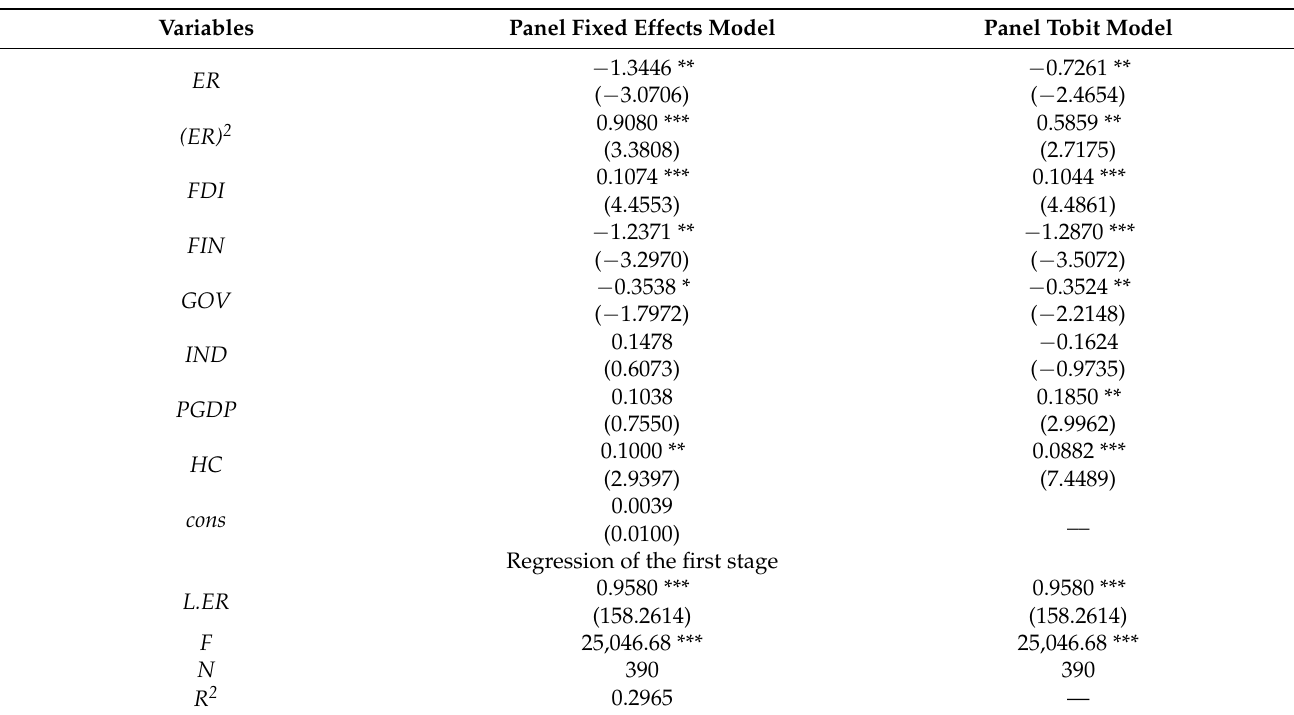
Table 5. Baseline regression